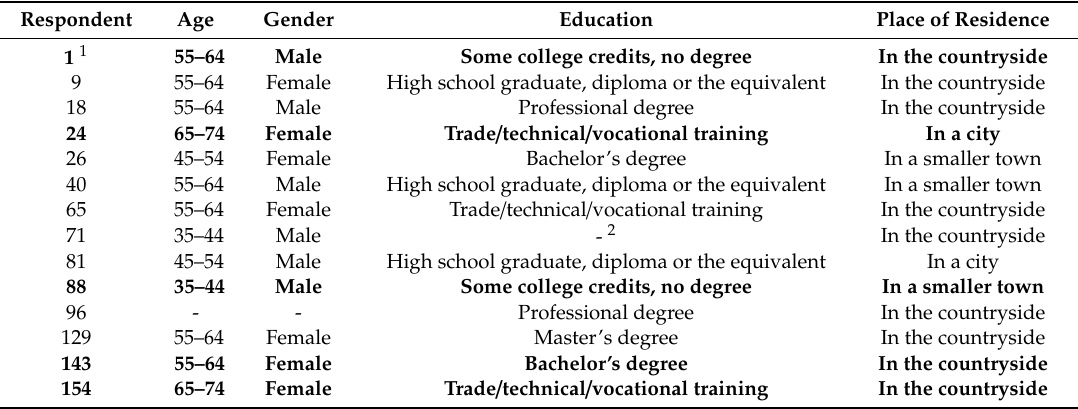
Table 1. Contextual factors of the